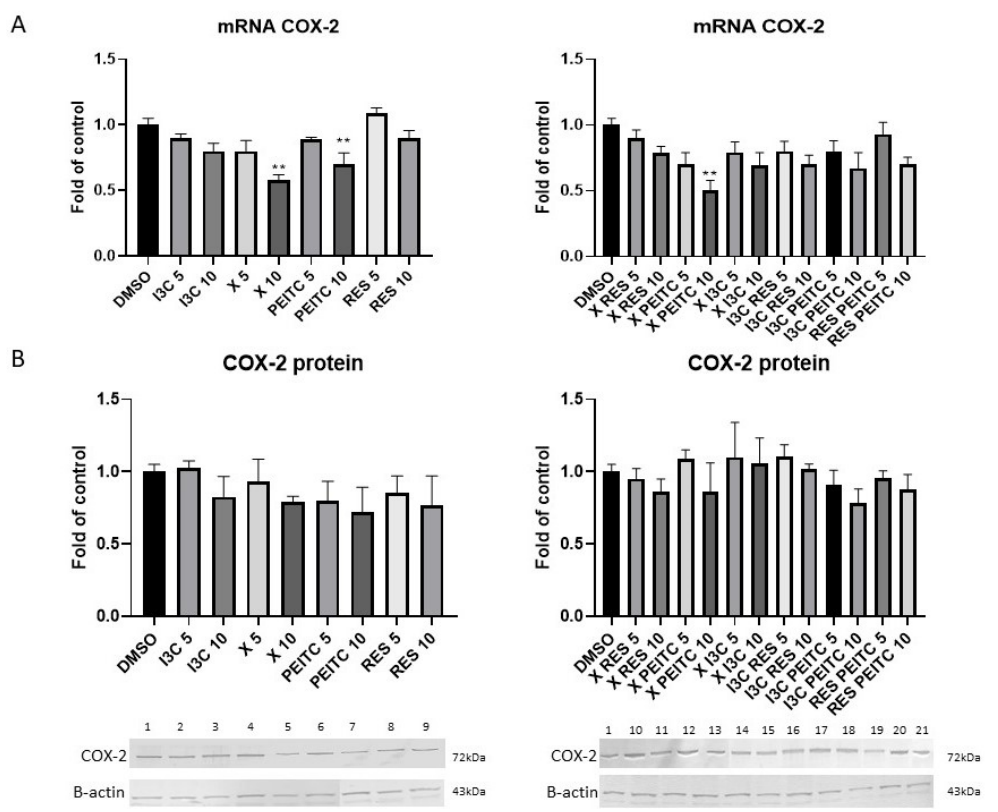
Figure 10. The impact of X, PEITC, RES, I3C, and their mixtures on the expression of COX-2 in HepG2 cells. Panel ( A )